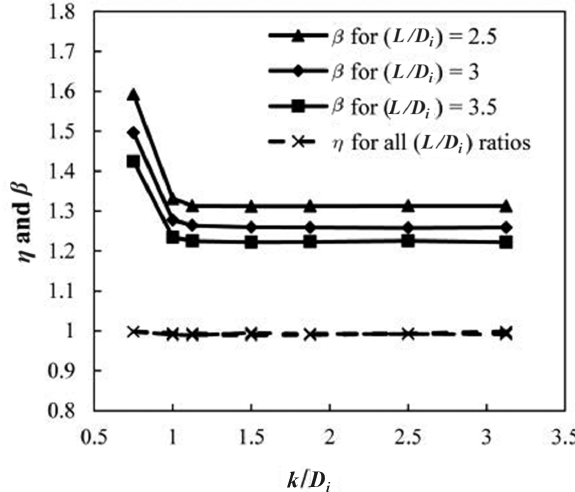
Figure 7: Variations of β and η parameters with various k / D i ratios; the ratio b / D i for the specimens was 0.25 for all cases.